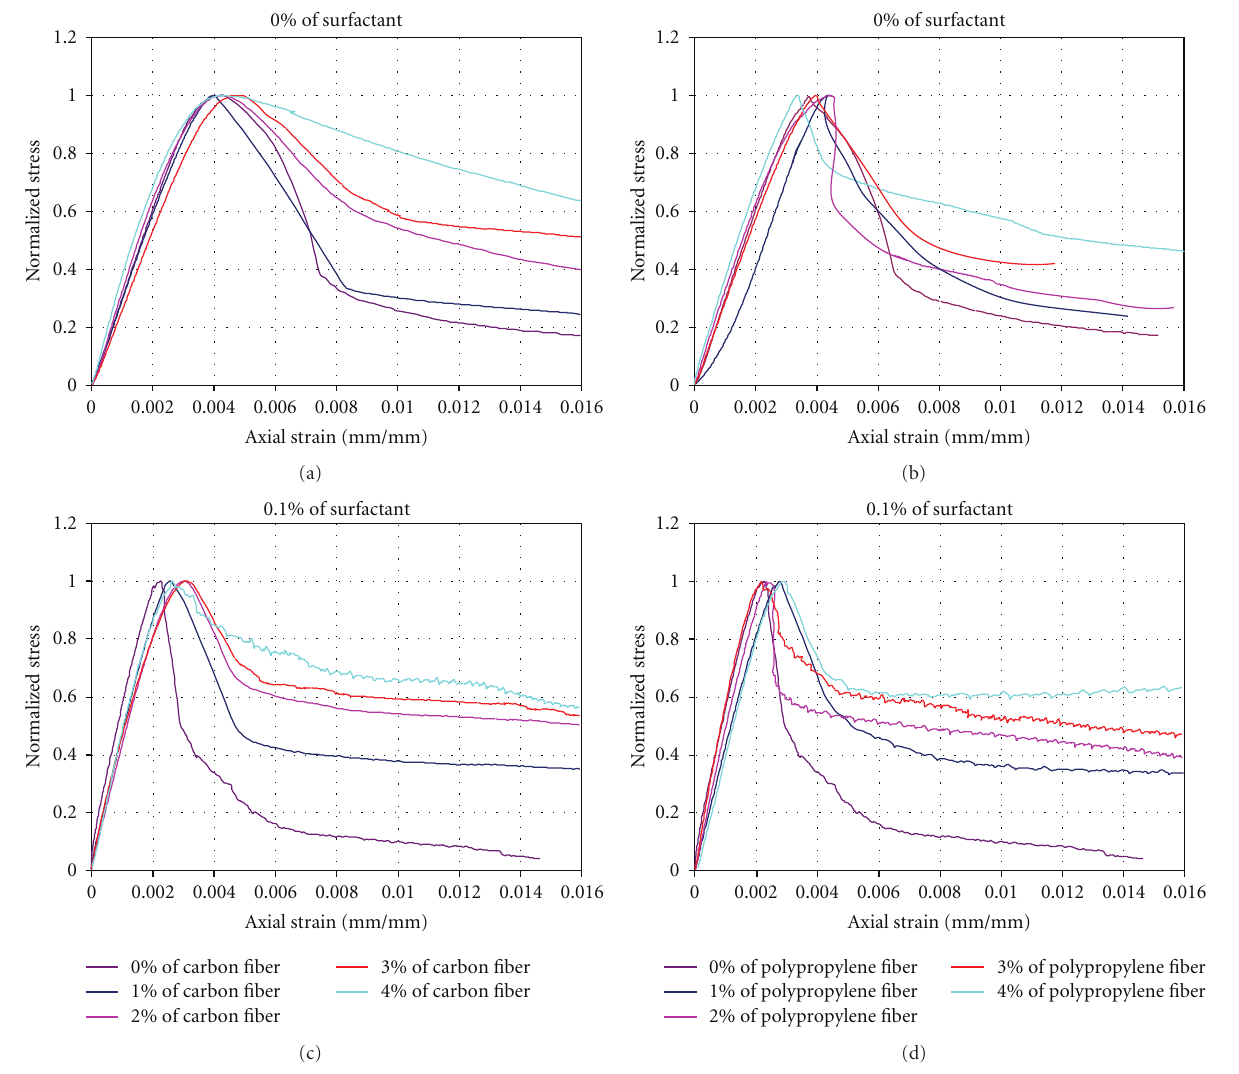
Figure 5: Normalized stress-strain curves for carbon and polypropylene